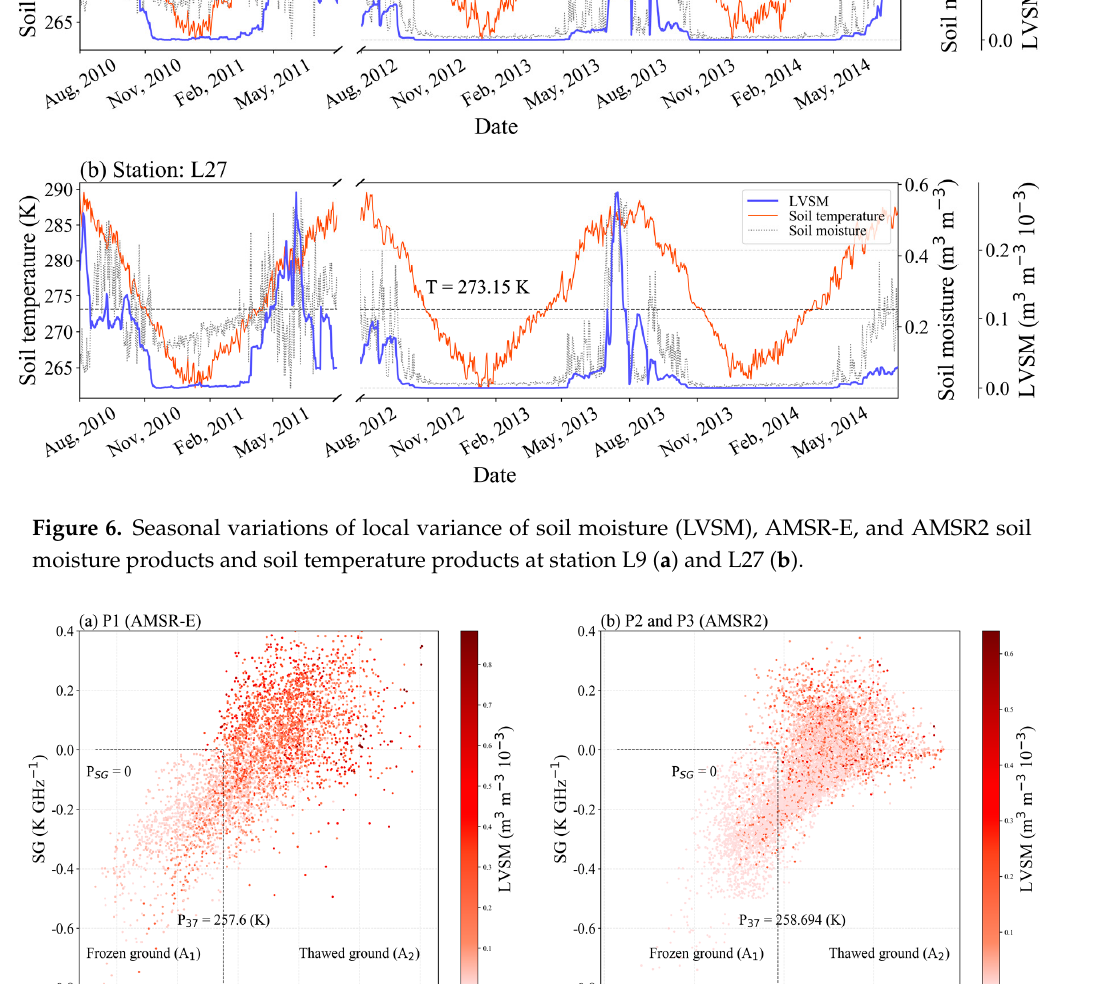
Figure 6. Seasonal variations of local variance of soil moisture (LVSM), AMSR-E, and AMSR2 soil moisture products and soil temperature products at station L9 ( a ) and L27 ( b ).